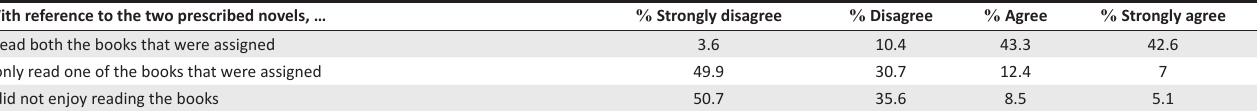
TABLE 4: Participants’ actions regarding